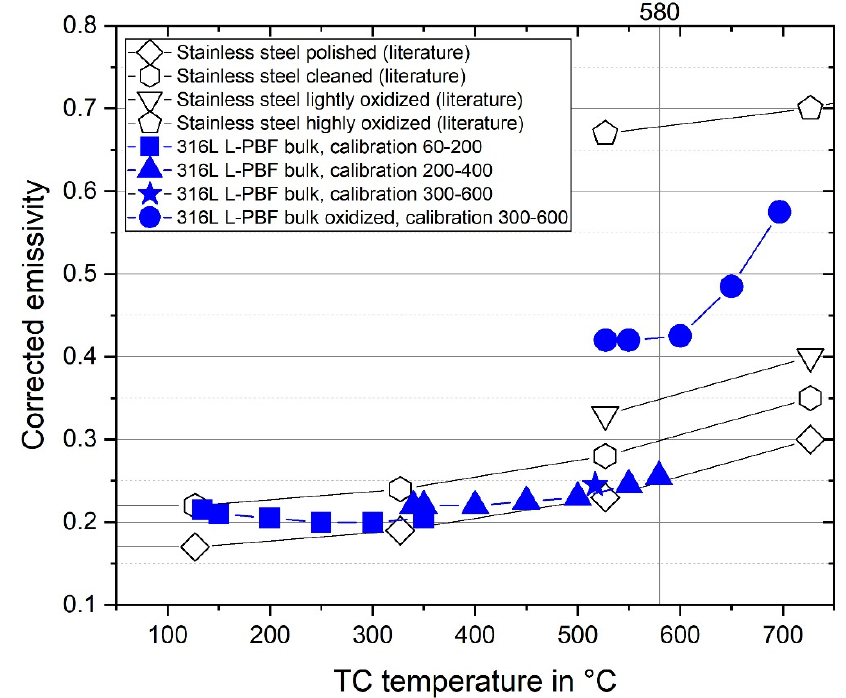
Figure 14. Corrected emissivity of 316L L-PBF bulk surface (blue symbols) over measured TC temperature. For comparison, temperature depend literature values of emissivity of stainless steel in different conditions (black hollow symbols) are added from [36].